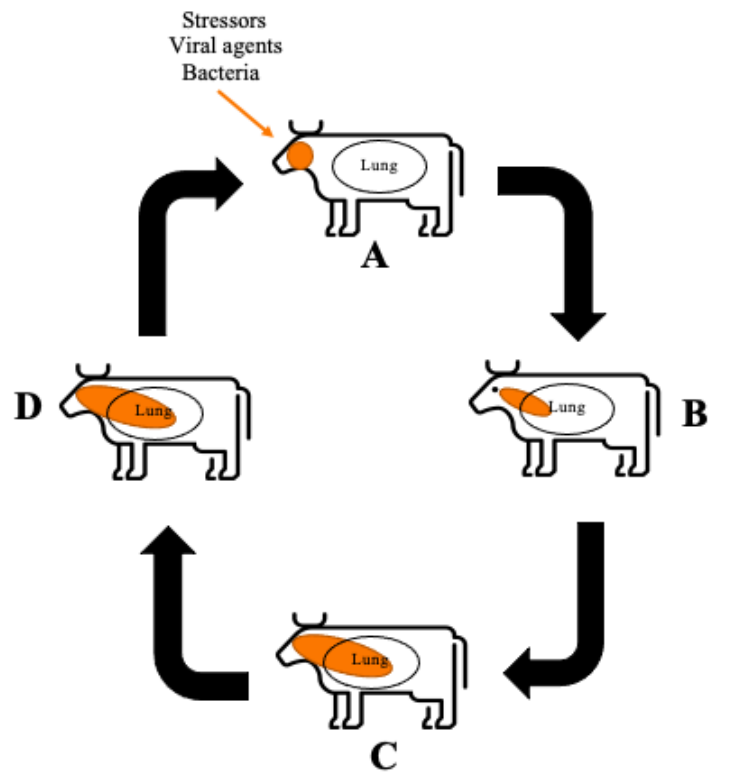
Figure 1. Schematic overview of BRD progression ( A ) The immune system is challenged allowing bacterial and viral infection to occur. Function of the ciliated epithelial cells is inhibited by necrosis or dysfunction. The immune system is activated via the PRR recognition of PAMPs. Neutrophils are recruited to the area as the first line of defence. ( B ) BRD causing bacteria proliferate in the upper respiratory area allowing infection of the bacteria into the lower respiratory area. The PRR recognise the PAMPs produced by the pathogens. Respiratory epithelial cells which contain TLR and NOD-like receptors also recognise PAMPs and in response produce pro-inflammatory cytokines. ( C ) Pro-inflammatory cytokines recruit a larger neutrophil response. Neutrophils undergo NETosis producing NETs stimulating cell death of surrounding pulmonary epithelial cells, resulting in pulmonary damage. ( D ) Persistent infection of BRD can occur through M. haemolytica producing a leukotoxin that binds to the [beta] 2 integrin impairing the function of leukocytes, resulting in apoptosis, allowing the bacteria to evade host detection.